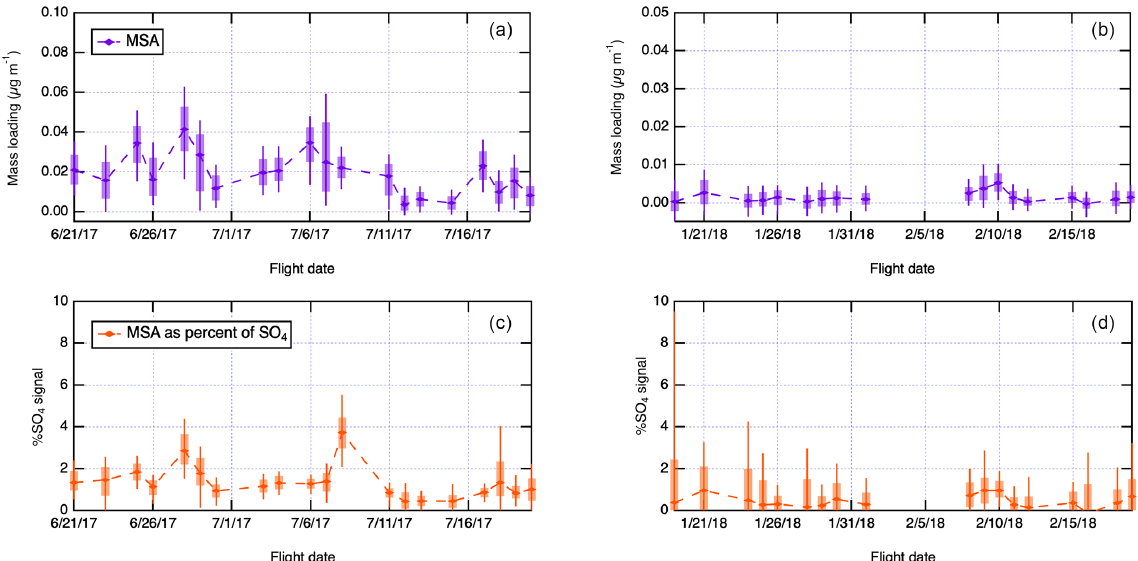
Figure 3. Summary of methanesulfonic acid (MSA) measurements derived from the AMS mass spectra collected during ACE-ENA and laboratory calibrations as described in the Experimental section, expressed as total particle-phase MSA (a, b) and percentage of total AMS sulfate signal (c, d) . Boxes are centered on daily medians, box boundaries extend between the 25th and 75th percentile, and whiskers extend between the 10th and 90th percentile. (a, c) IOP 1 measurements. (b, d) IOP 2 measurements. Panels (a) – (d) are for an altitude window <